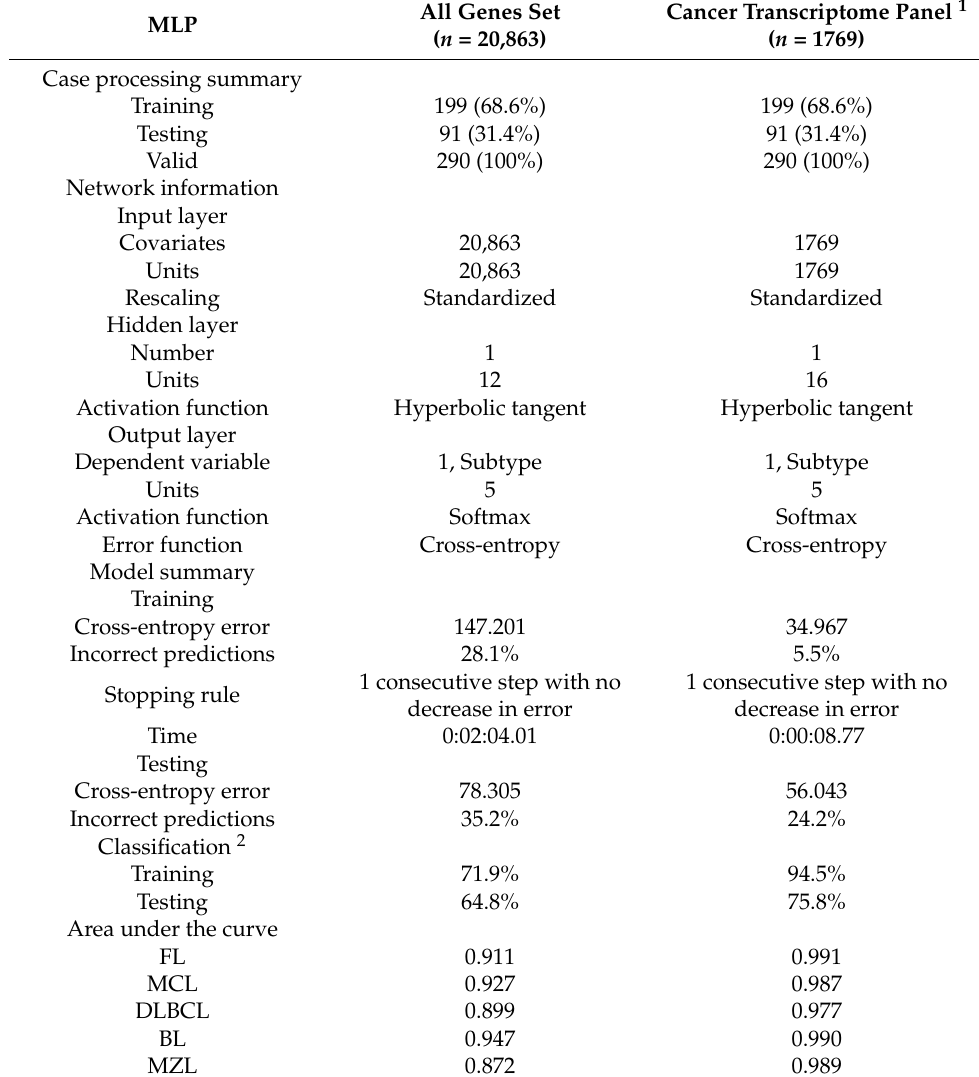
Table 1. Prediction of the NHL subtypes by all genes of the array and the cancer transcriptome panel using multilayer perceptron